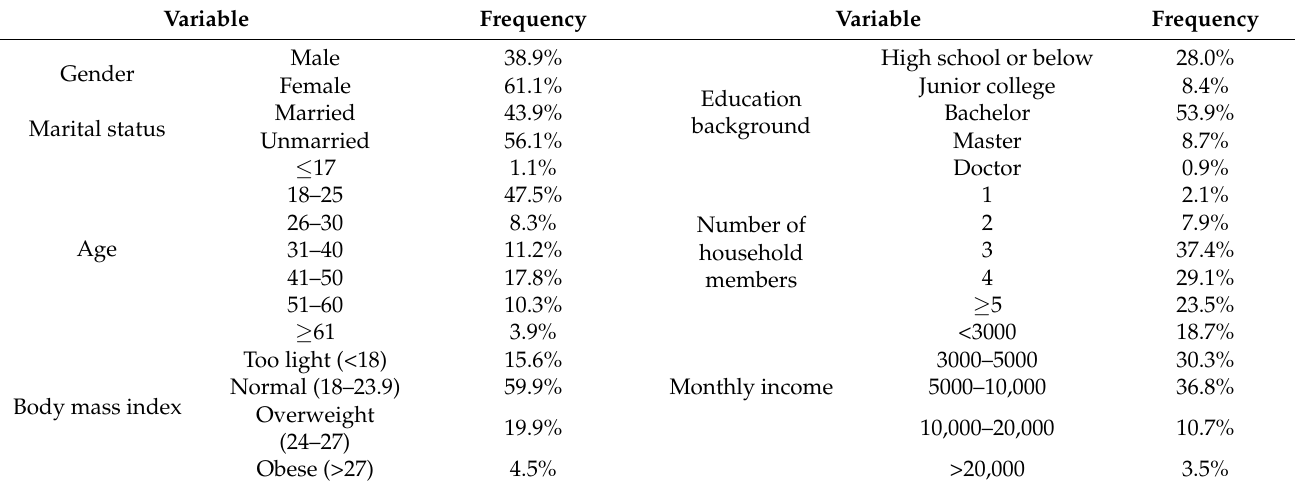
Table 1. Demographic characteristics of the